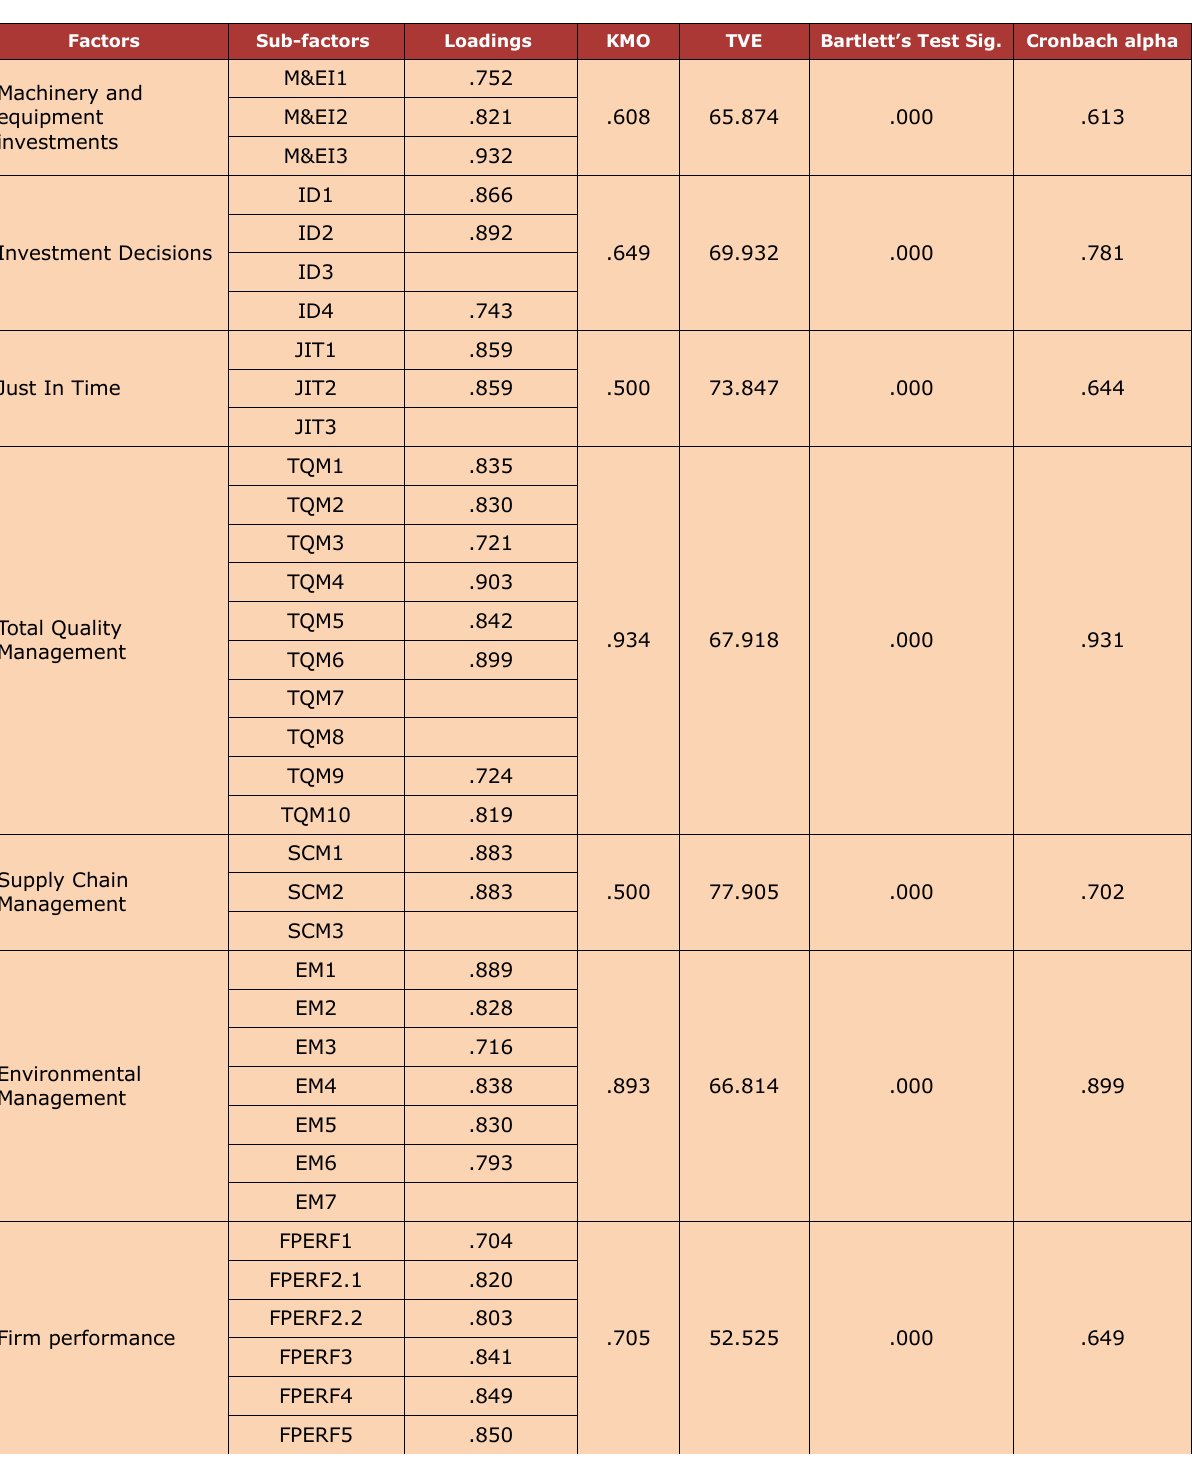
Table 2. Unidimensionality and reliability